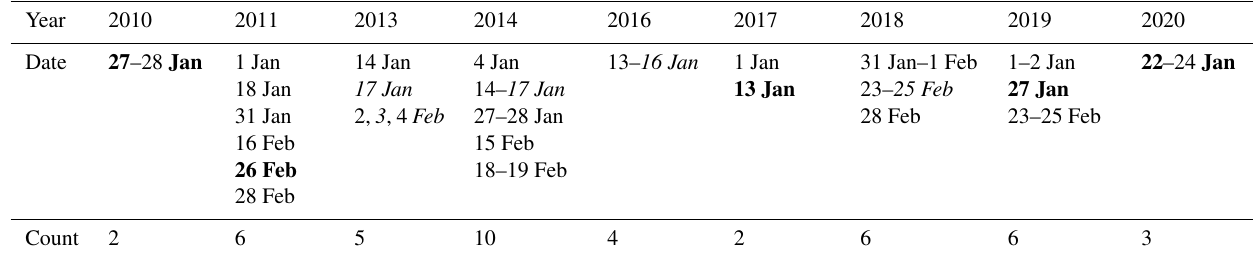
Table 2. The 44 EDI days from the quasi-climatological period shown in bold/italic print if belonging to the 5 EDI days with the low- est/highest daily mean low-level divergence at the BCO. Years 2012 and 2015 are not shown because they have no EDI days. Data: